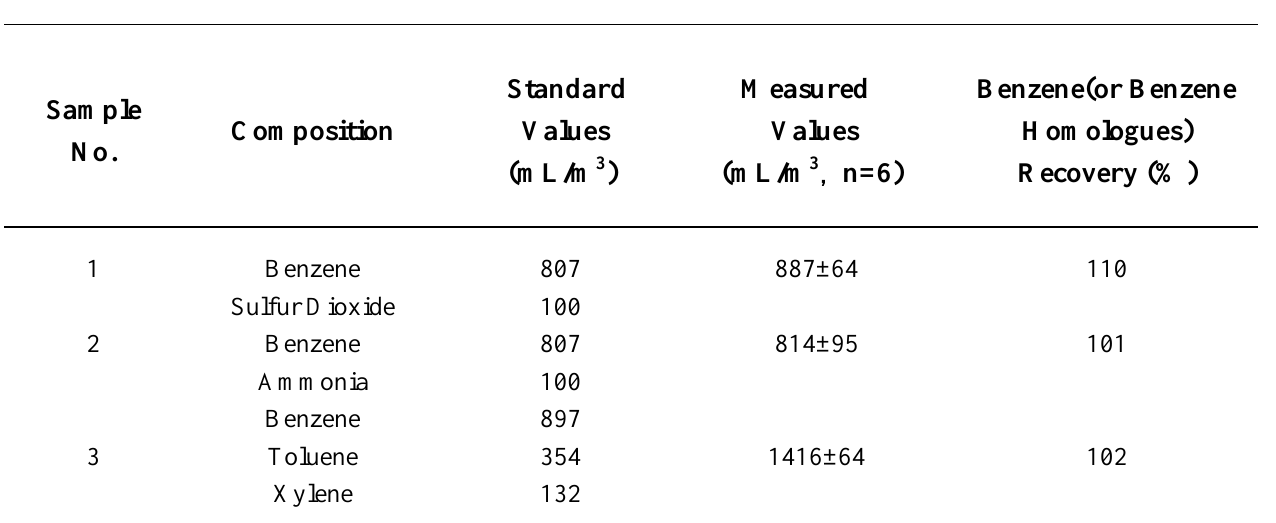
Table 3. The analysis of benzene or benzene homologue vapors in artificial